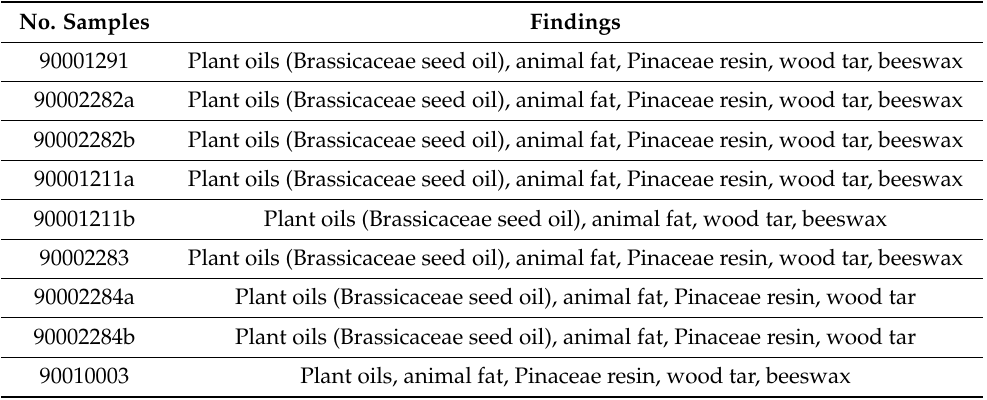
Table 6. Chemical composition of the studied balms. No.